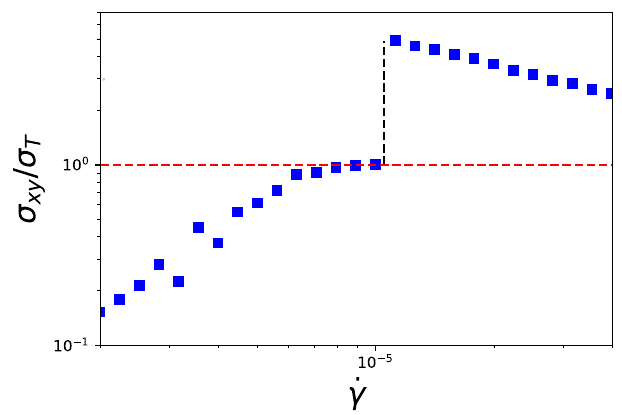
Fig. 1 Onset stress of discontinuous shear thickening (DST). Shear stress rescaled by a stress scale given by the granular temperature, versus the shear rate _ γ , provides the onset of DST. The system undergoes discontinuous shear thickening when the rescaled stress exceeds unity, and the red dashed line is a guide for eye to mark the threshold. This threshold behavior is akin to that of a Brownian suspension near DST 18 . Each point is an average over a total strain of 20, with the number of con fi gurations equal to the total strain. The packing fraction is ϕ = 0.81, the number of particles is N = 16,384, and the system size is L ¼ smaller than